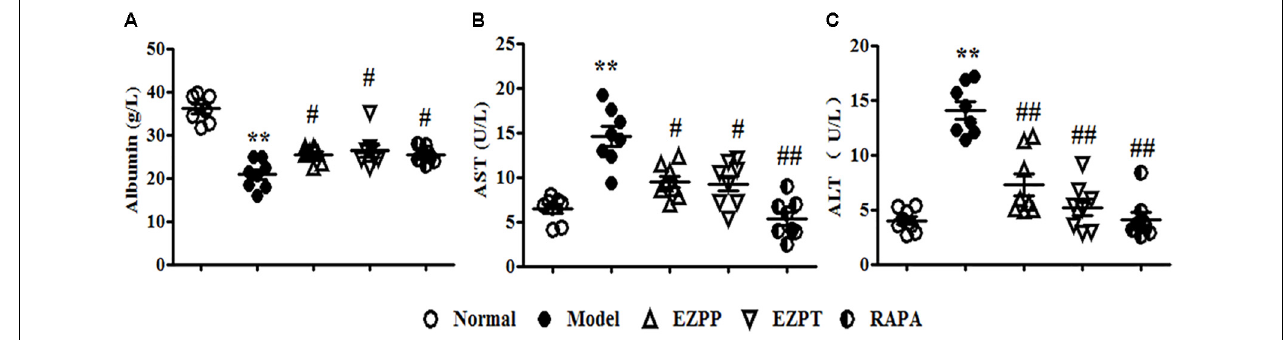
FIGURE 1 | Levels of albumin, AST and ALT in serum. An array of parameter in serum enzyme activity was used to evaluate liver function. These parameters included albumin (A) , AST (B) , and ALT (C) . Data are expressed as mean ± SEM ( n = 8). ∗∗ p < 0.01 versus Normal group; # p < 0.05 and ## p < 0.01 versus Model group.